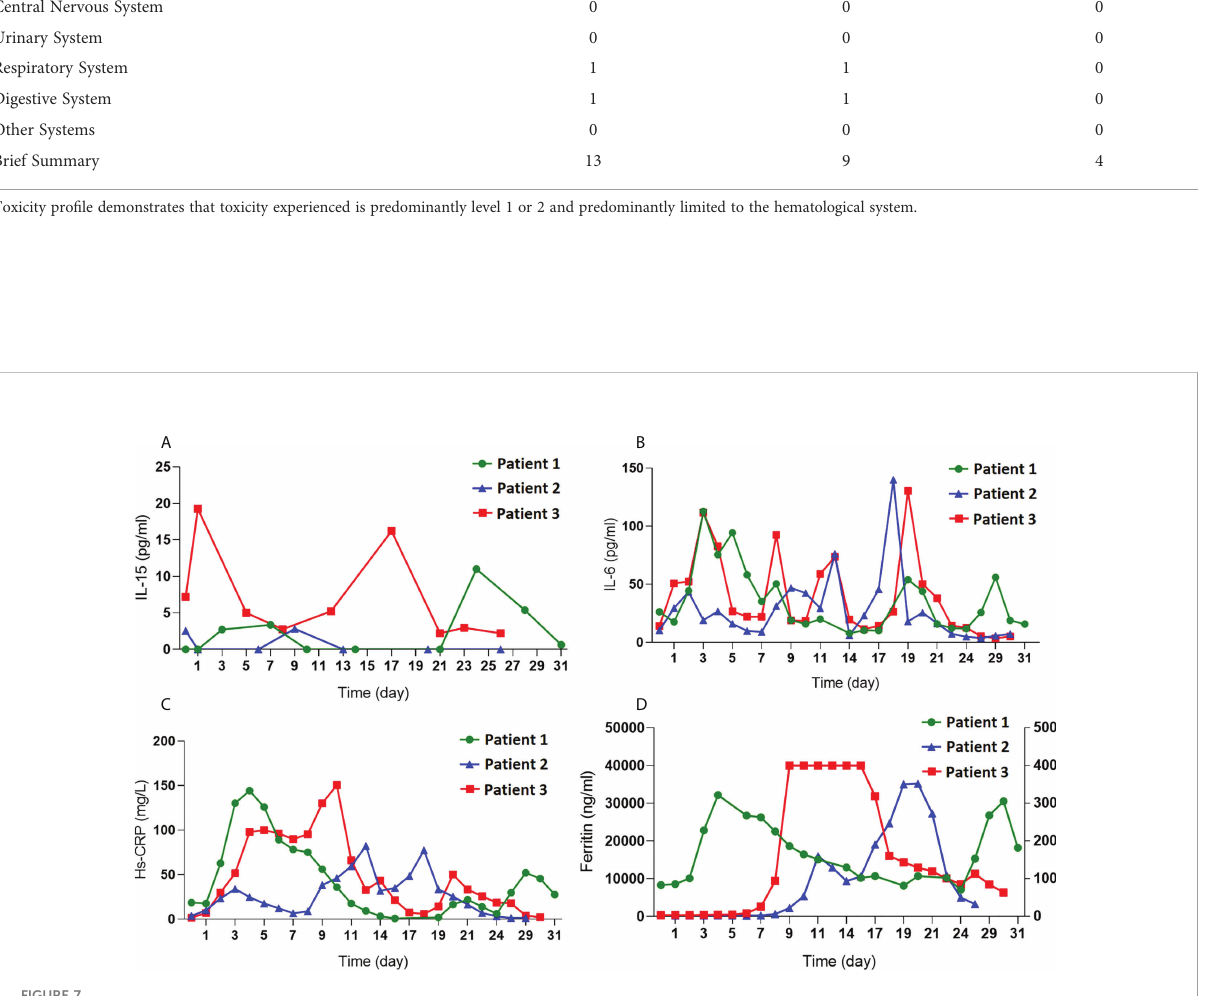
Level 1 or 2 Level 3 or 4 (number of patients) (number of patients) (number of patients)